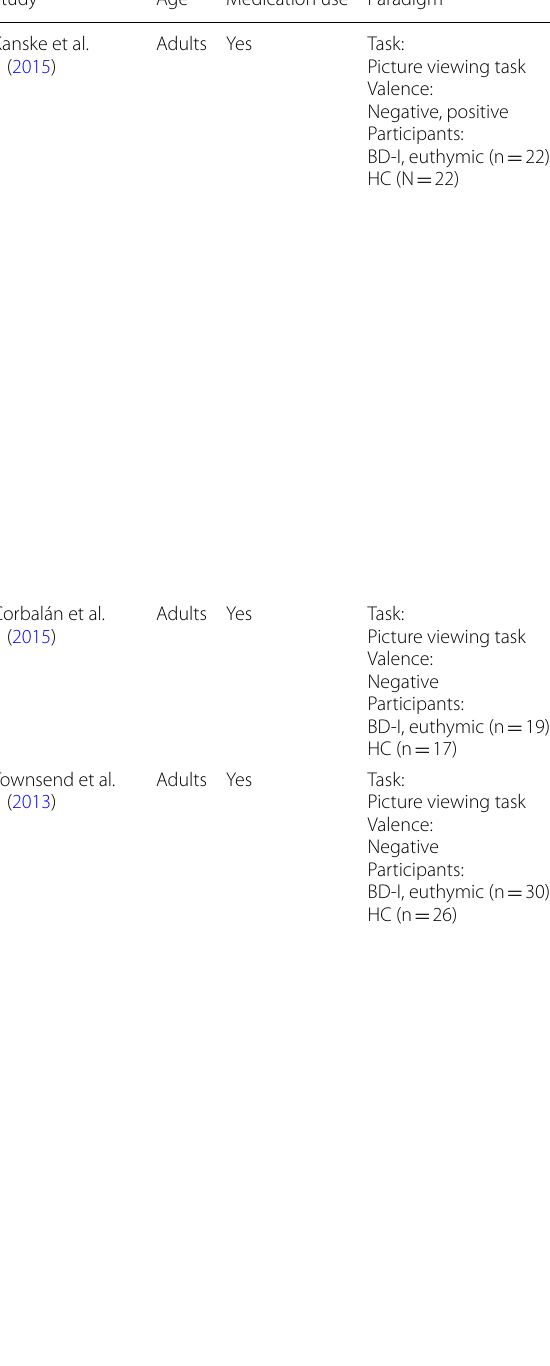
Table 6 Studies that investigated reappraisal in euthymic BD patients